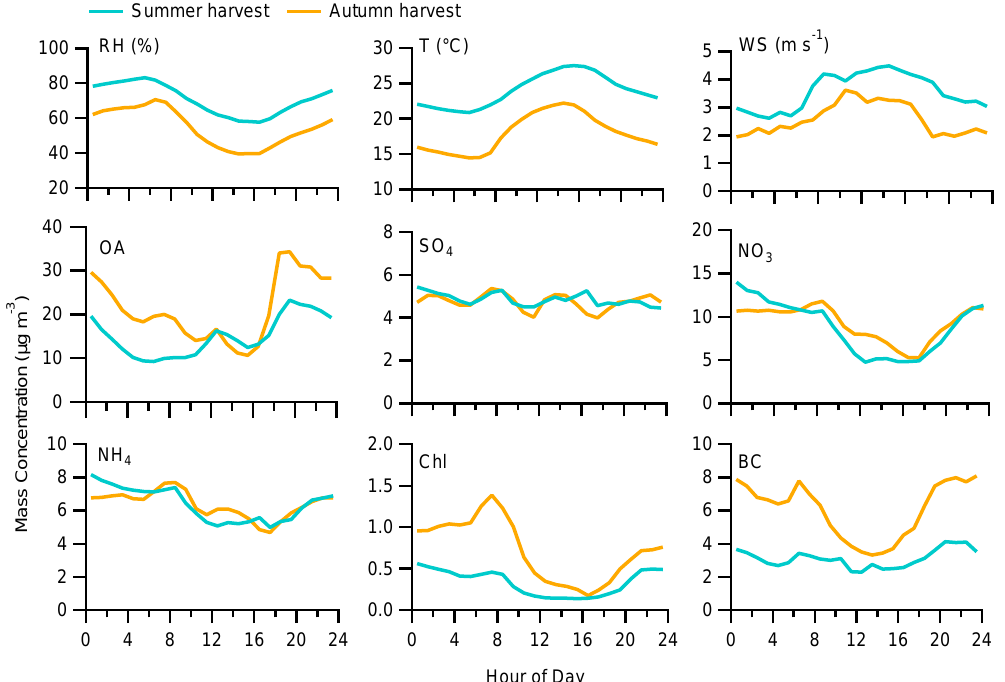
Figure 2. Diurnal variation patterns of meteorological factors (i.e., RH, T , and WS) and PM 1 species including organic aerosol (OA), nitrate (NO 3 ) , sulfate (SO 4 ) , ammonium (NH 4 ) , chloride (Chl), and black carbon (BC) during the harvest